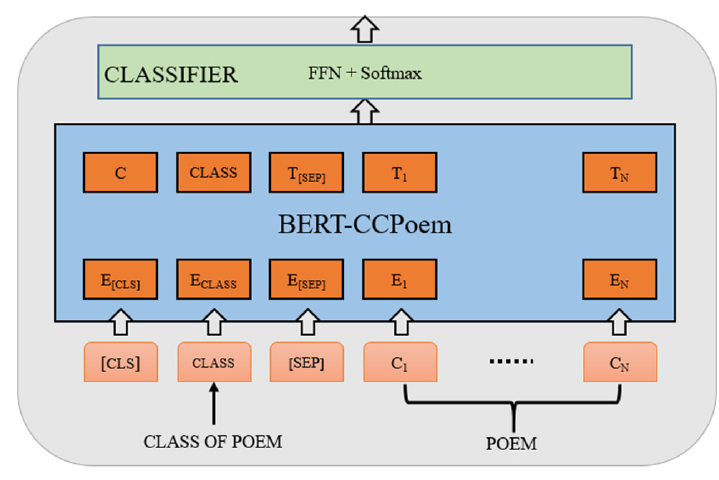
Figure 3. The text-fluency-checker fine-tuned on BERT-CCPoem.